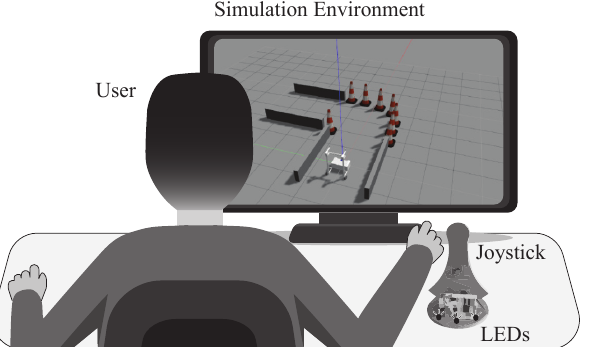
Figure 1. System proposed to provide visual feedback in teleoperation applications of smart